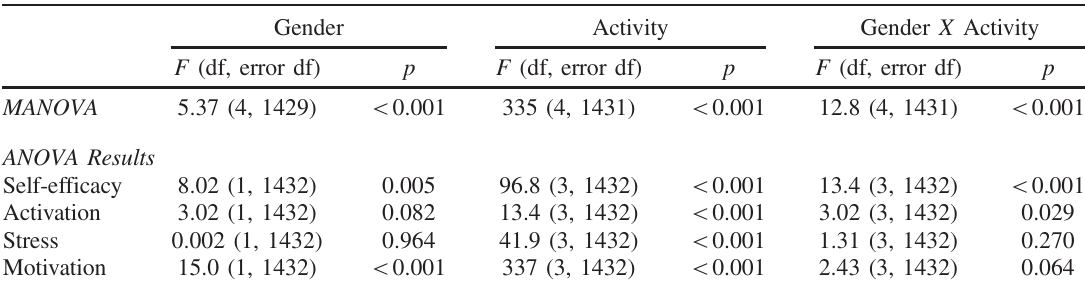
TABLE III. MANOVA and ANOVA results for affective state